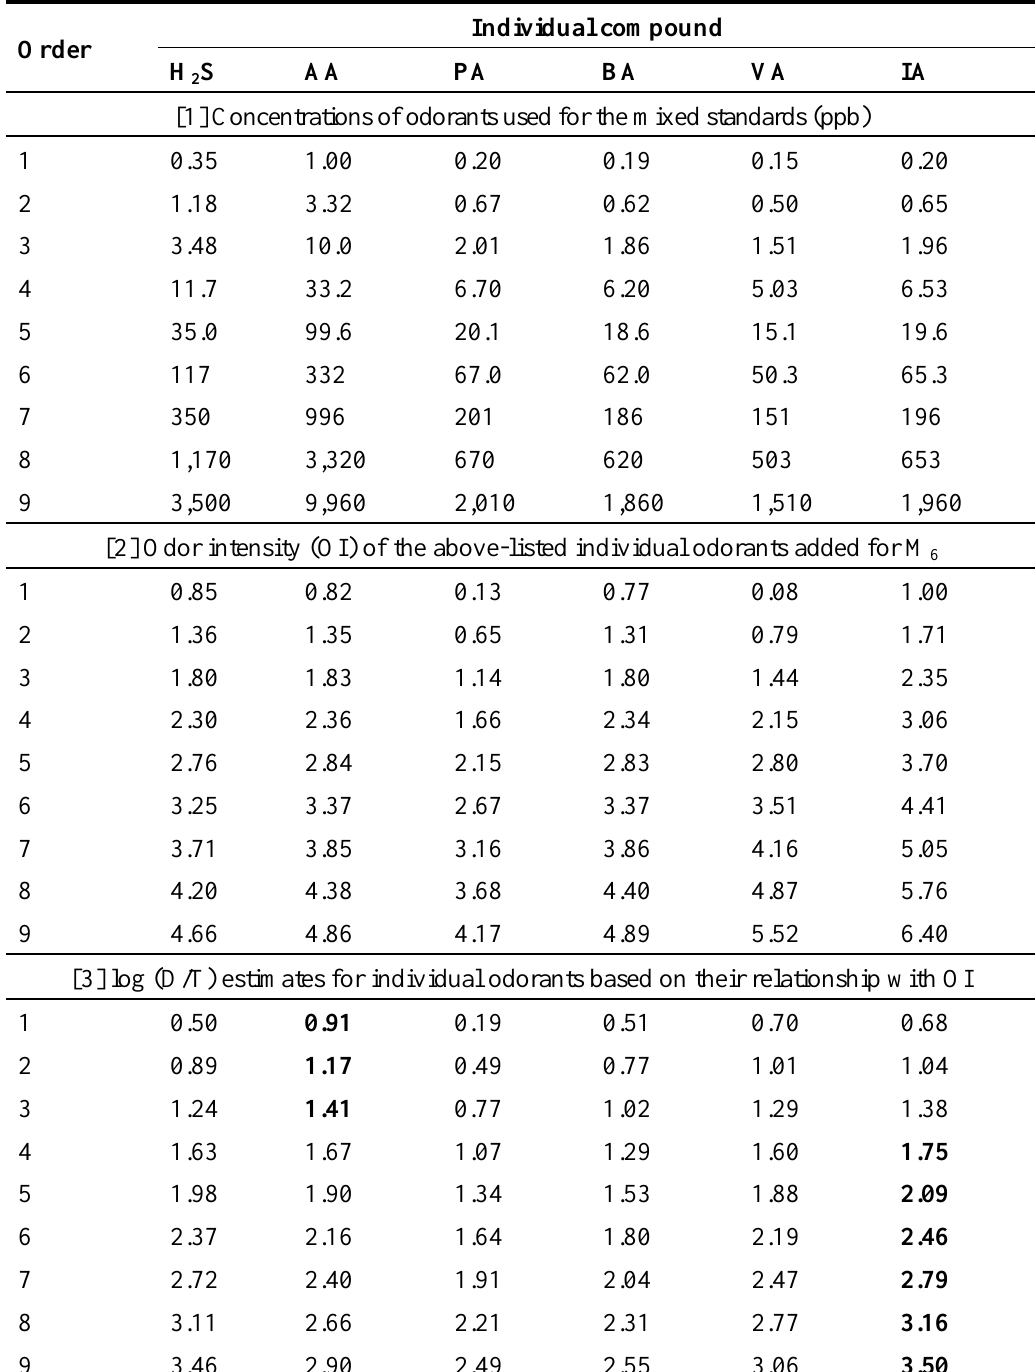
Table 4. Preparation of odor mixture consisting of six compounds (M relationship between odor intensity and dilution-to-threshold (D/T) ratio a